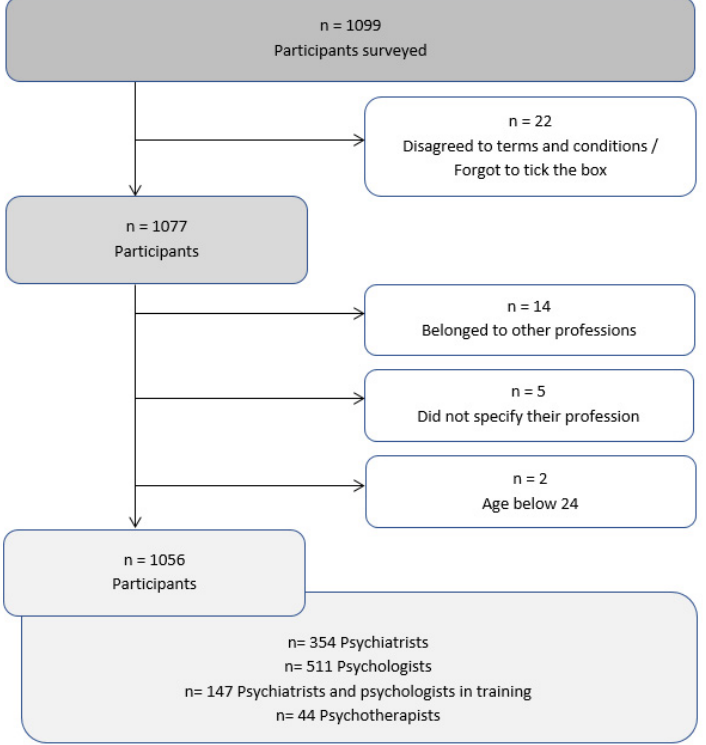
Figure 1. Overview of participants surveyed.